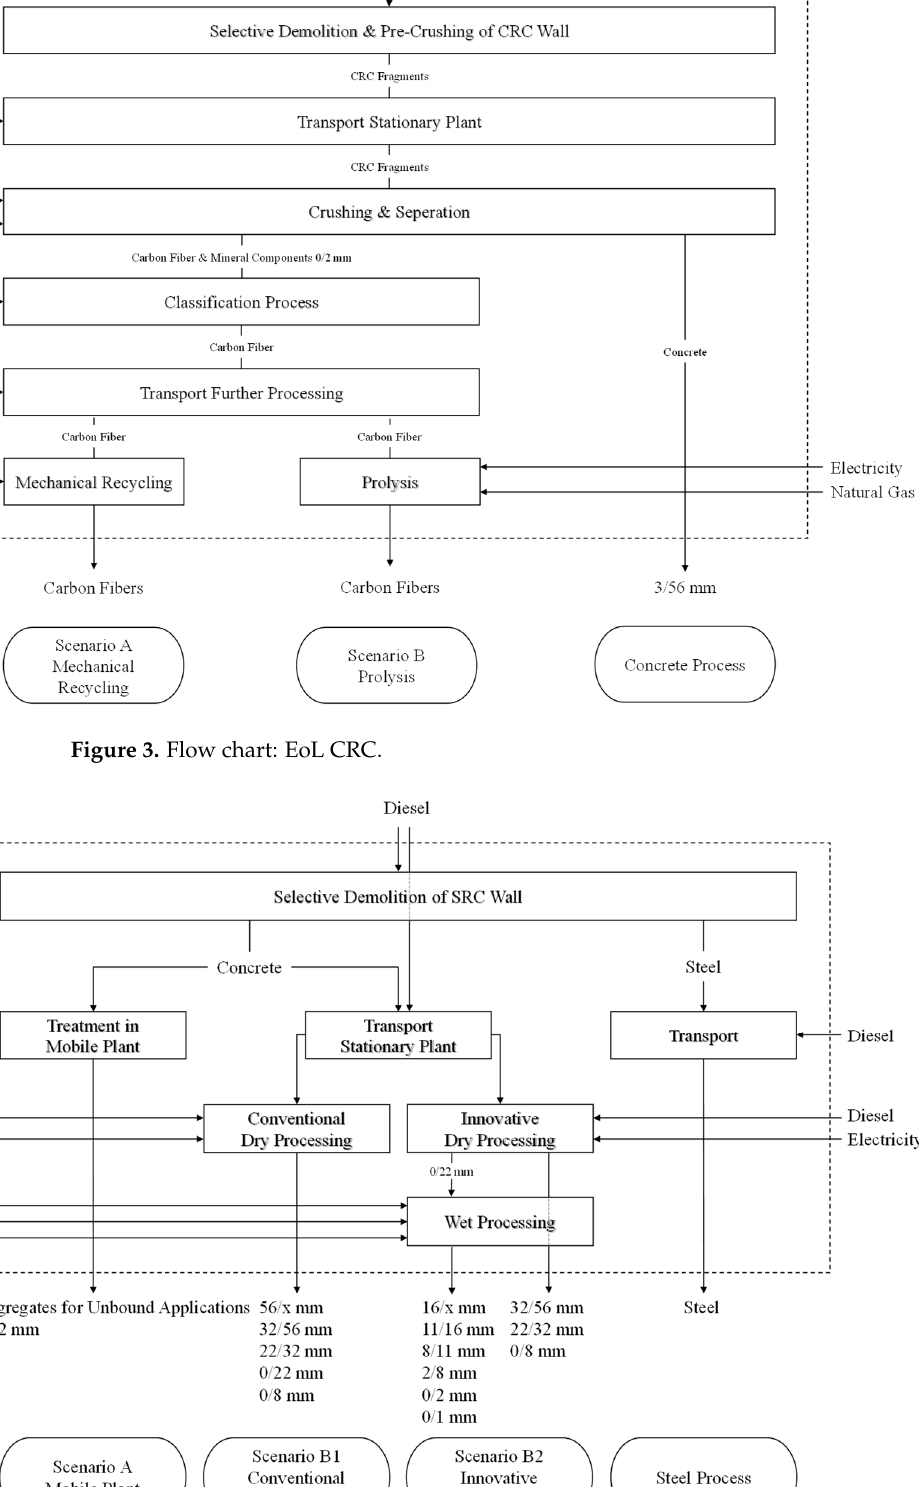
Figure 4. Flow Chart: EoL SRC.